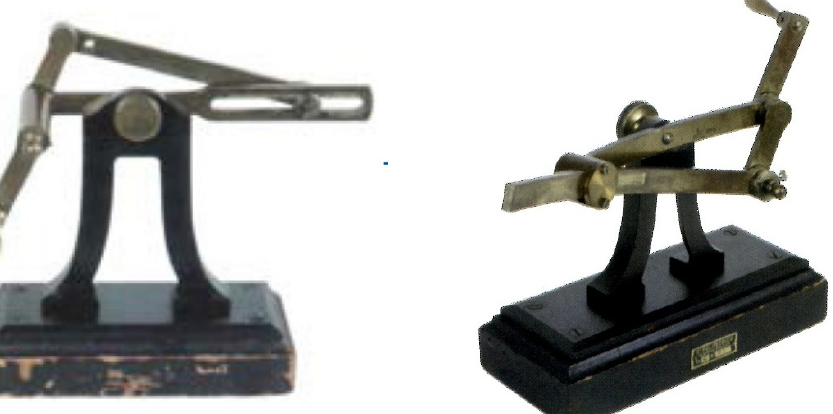
Figure 19. Examples of the iron-made crank-slider mechanism models from the 1930s’ within the collection at the Department of Mechanics,